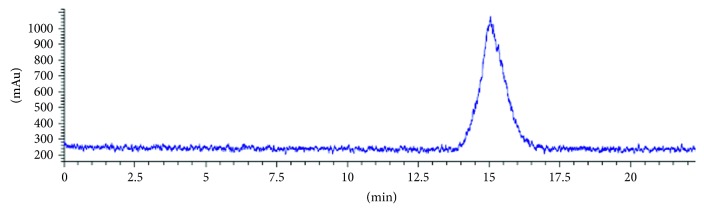
HPLC chromatograms of [18F]-FP-chlorotoxin.